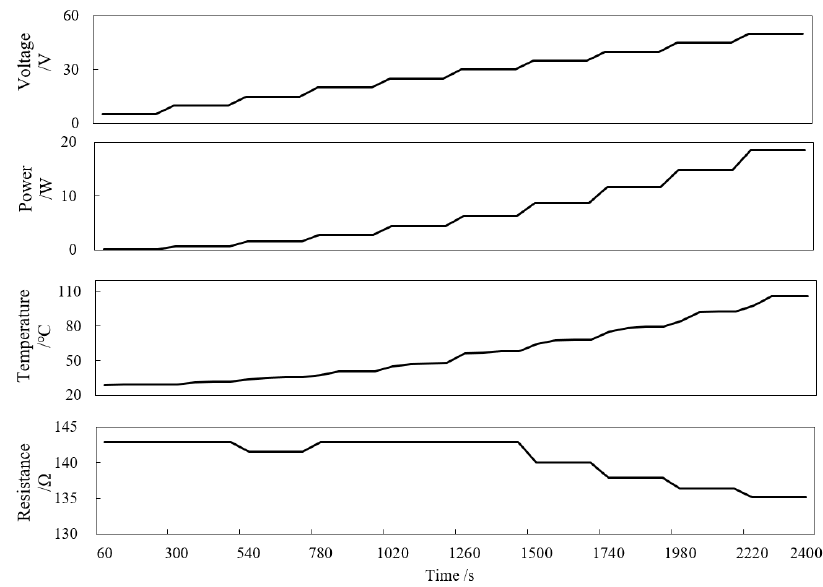
Figure 11. Electrothermal characteristics of single heating fiber.